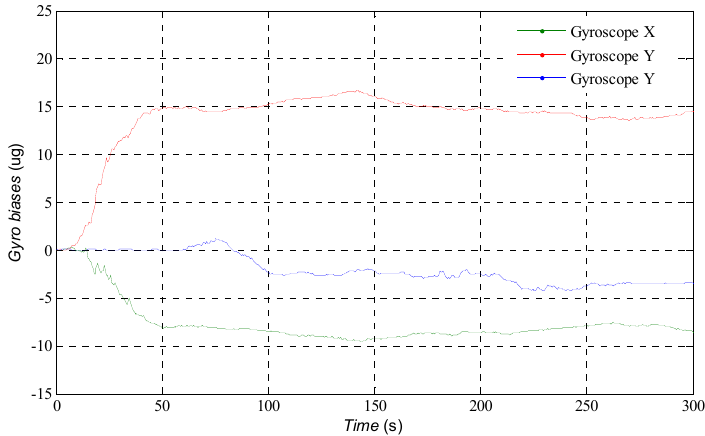
Figure 7. Estimation of the gyroscope bias.